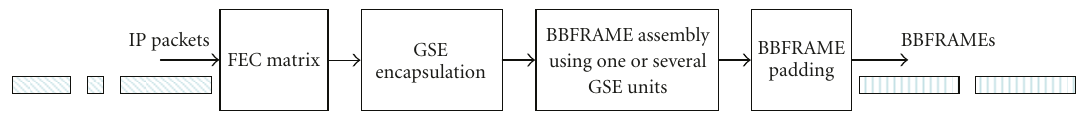
Figure 6: Steps involved in